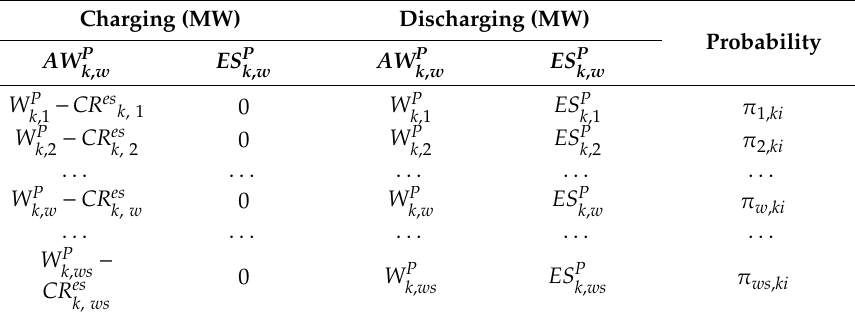
Table 1. Integrated power probability table